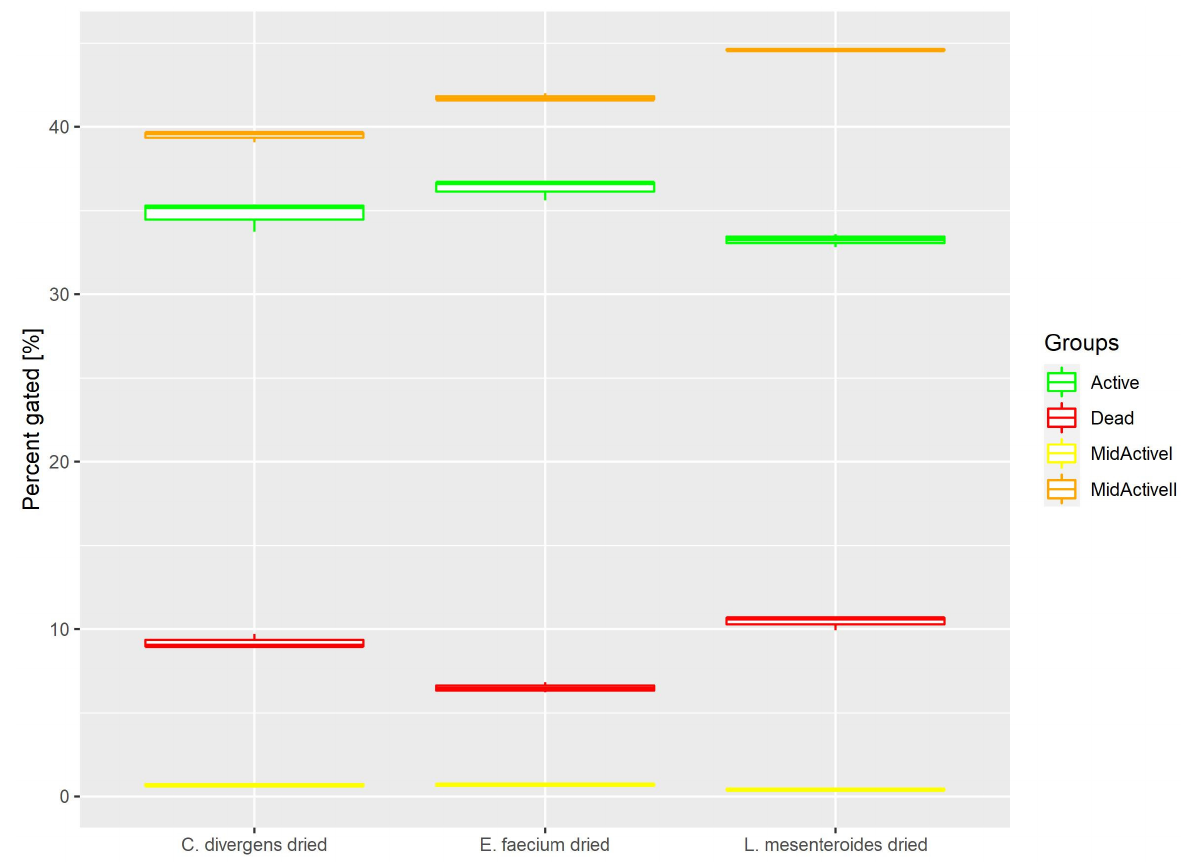
Figure 7. Cell subpopulation percentages in samples after fluid bed drying.